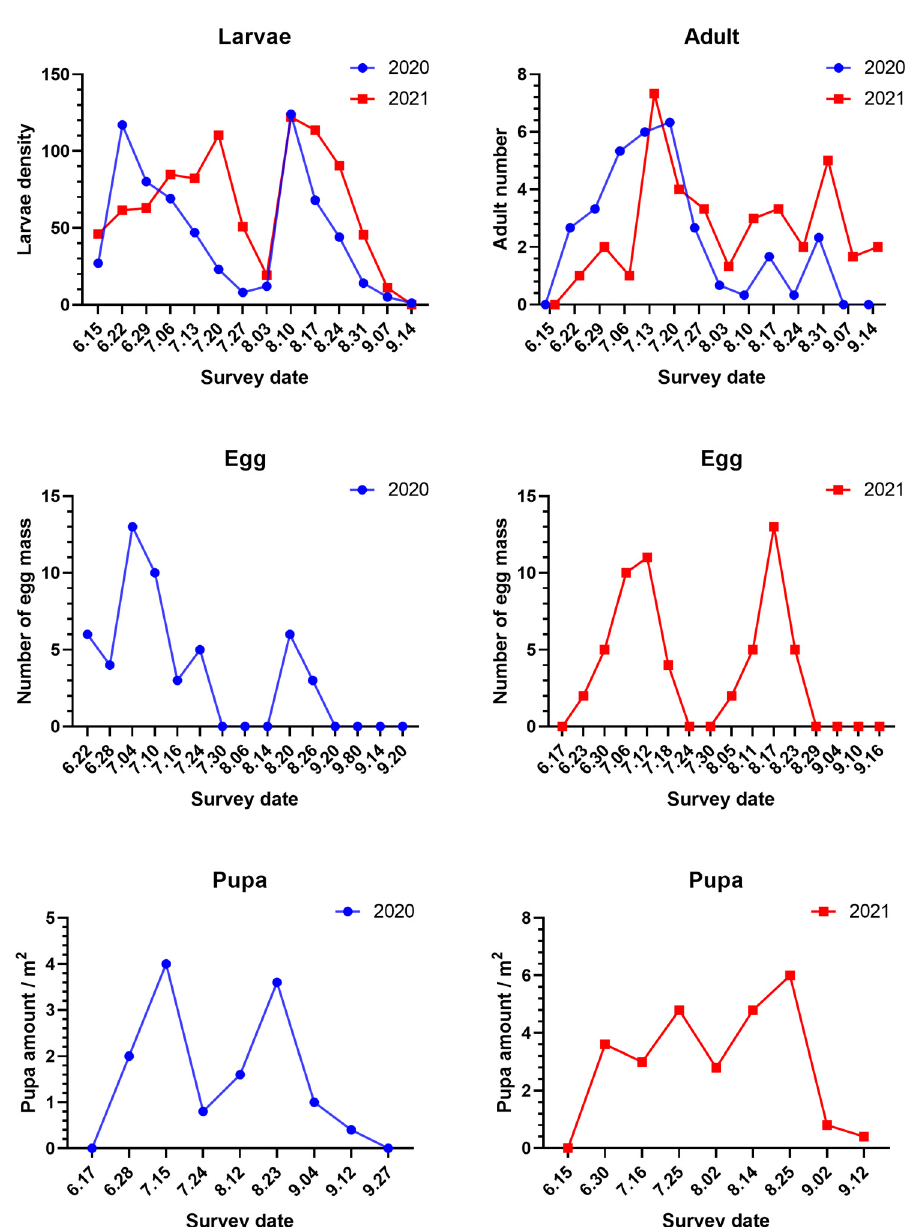
Figure 1. The population dynamics and occurrence of Spodoptera frugiperda at different stages in mountain maize fields. The larval density expresses the number of larvae per one hundred maize plants, the adult number indicates the number of adults per trap, and the number of egg masses is the number of egg masses per hundred maize plants.